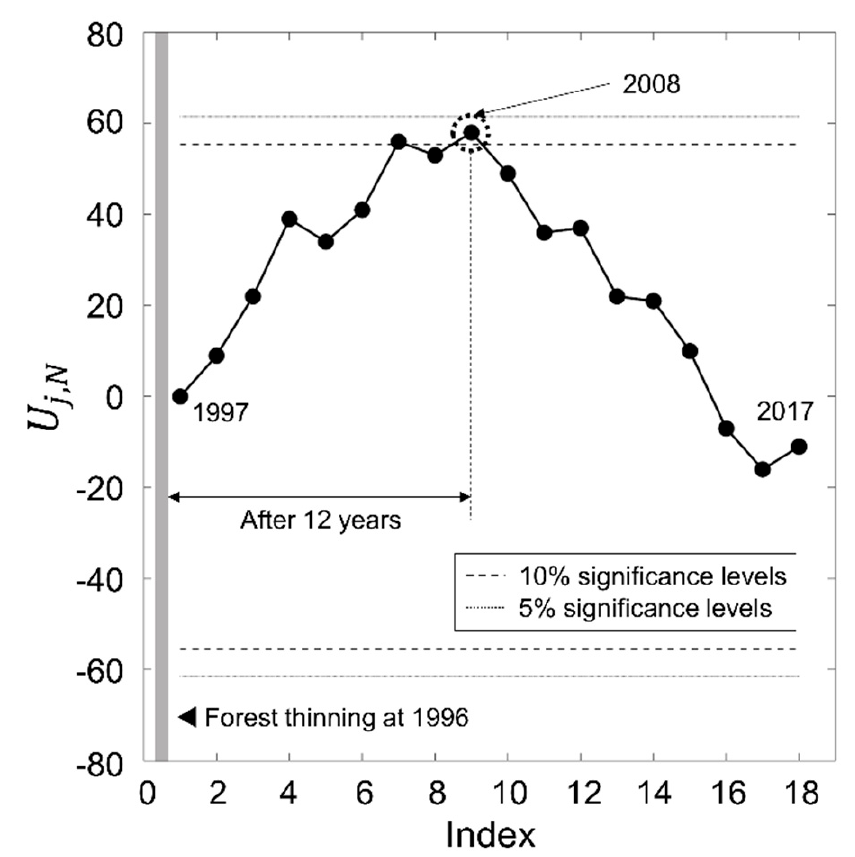
Figure 6. Pettitt’s test of the GCP forest catchment after forest thinning. The test statistics corresponding to 2008 are in the rejection region.